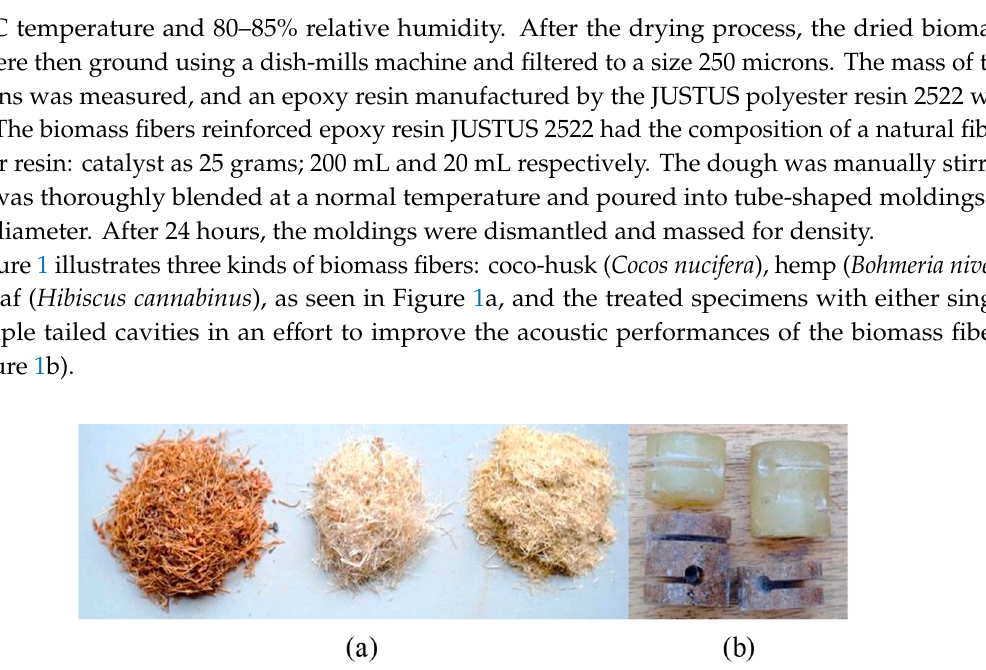
Figure 1. ( a ) The biomass: coco-husk, hemp, and kenaf respectively; ( b ) specimens with tailed cavity treatment.